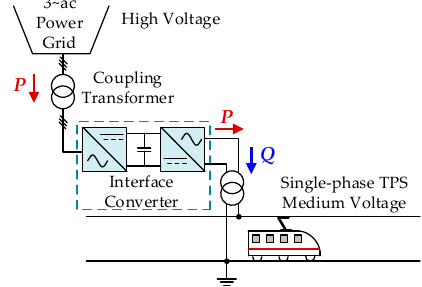
Figure 30. Interface converter between the high-voltage three-phase power grid and the Figure30. Interfaceconverterbetweenthehigh-voltagethree-phasepowergridandthemedium-voltage medium-voltage single-phase traction power system (TPS). single-phase traction power system